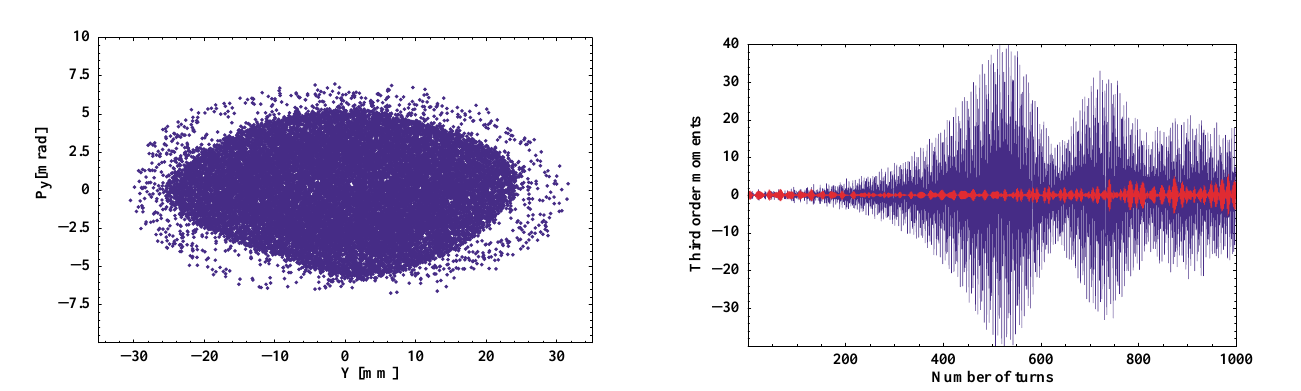
FIG. 10. (Color) Time evolution of (cid:5) x 3 (cid:6) (red) and (cid:5) y 3 (cid:6) (blue) for (cid:1) n x , n y (cid:2) (cid:1) (cid:1) 5.57, 5.54 (cid:2) in normalized